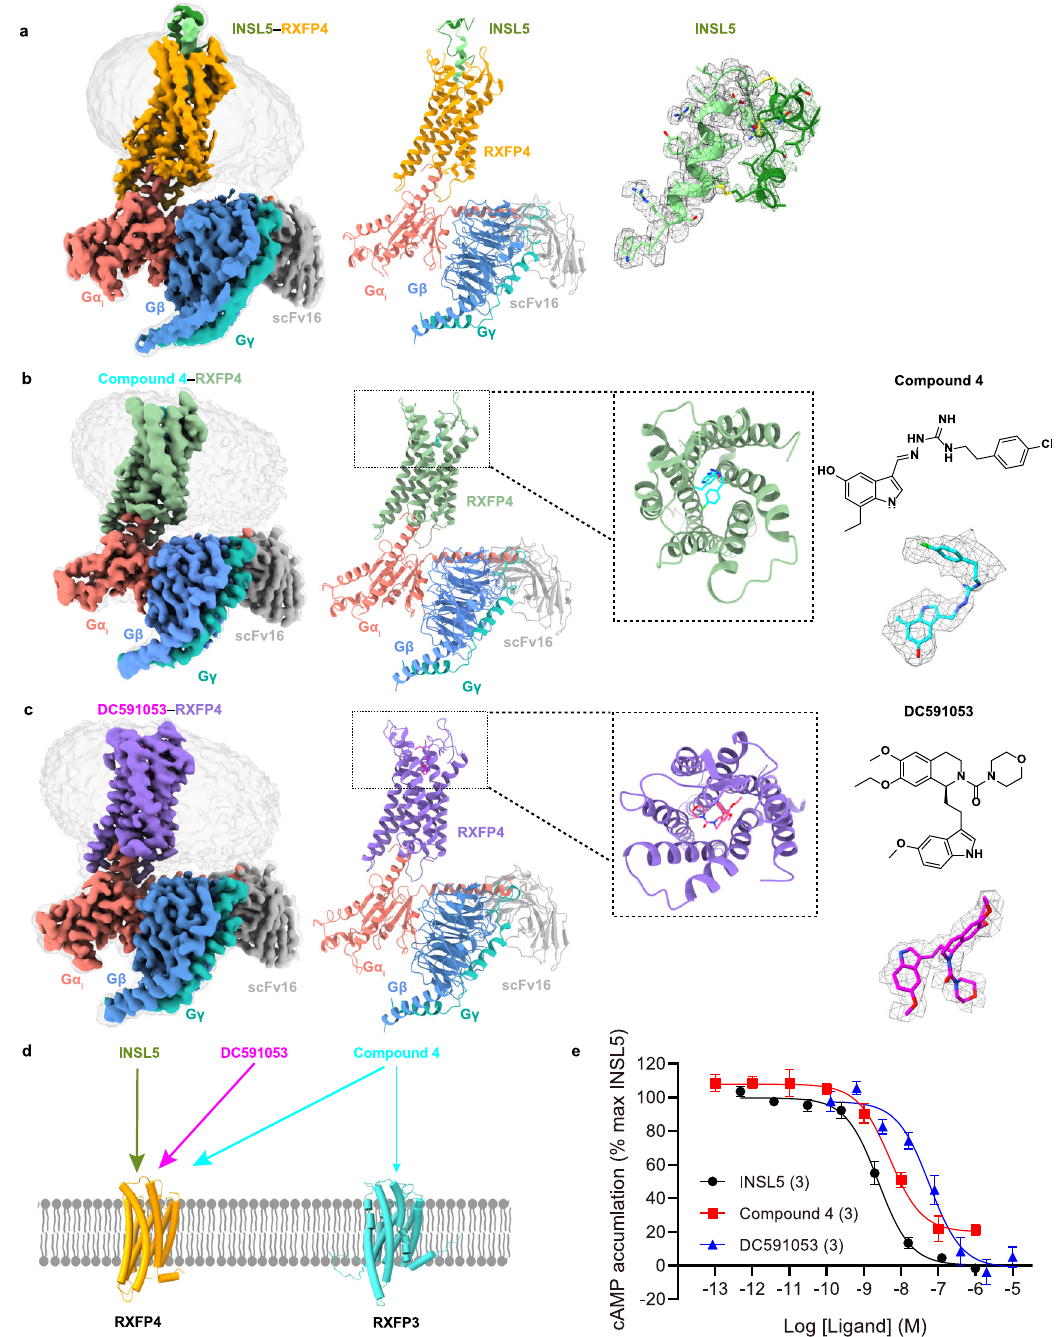
Fig. 1 | Cryo-EM structures of the RXFP4-G i complexes. a – c Cryo-EM density maps (left panel) and cartoon representation (middle) of the INSL5 − RXFP4 − G i − scFv16 complex ( a ), compound 4 − RXFP4 − G i − scFv16 complex ( b ) and DC591053 − RXFP4 − G i − scFv16 complex ( c ). Atomic models and EM den- sities of the three ligands are shown as sticks and surfaces, respectively. The A chainofINSL5isshowninforestgreenandtheBchaininlightgreen,compound4 in cyan and DC591053 in magenta. The corresponding RXFP4 is shown in orange,